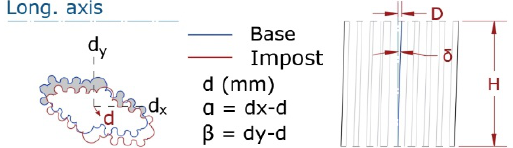
Figure 5: Two-dimensional parameters of the horizontal displacement.